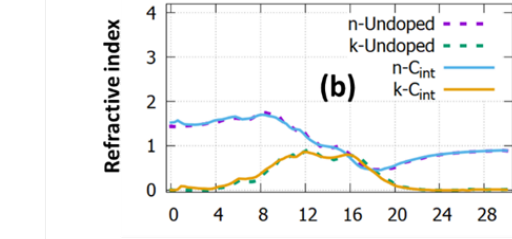
Figure 3. The refractive index of ( a ) C O : SnO 2 and ( b ) C i : SnO 2 .